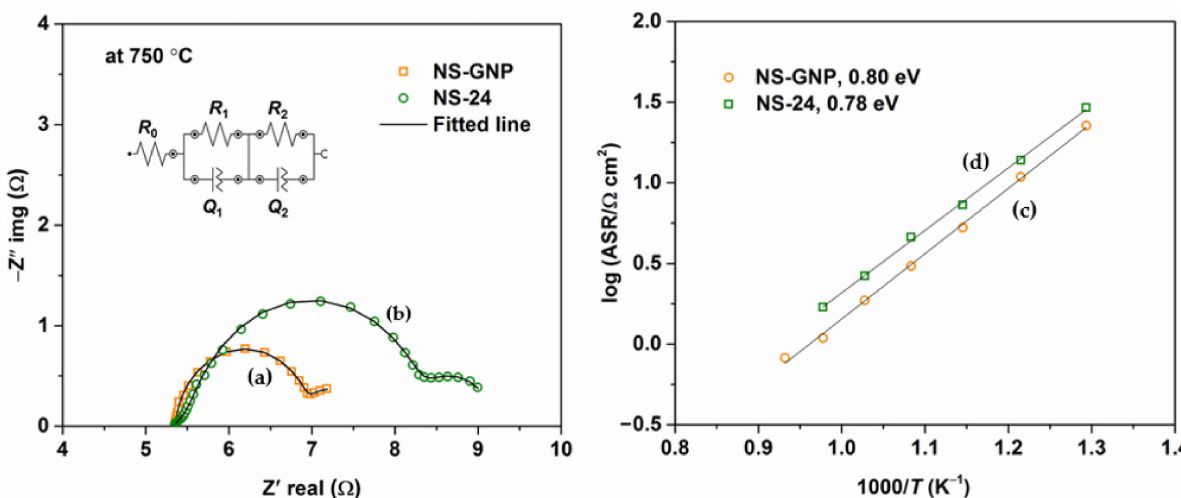
Figure 9. Impedance spectra of ( a ) NS-GNP and ( b ) NS-24 measured at 750 ◦ C and an equivalent circuit used to fit in the impedance circuit (inset); Arrhenius plots of the ASR values of the ( c ) NS-GNP and ( d )